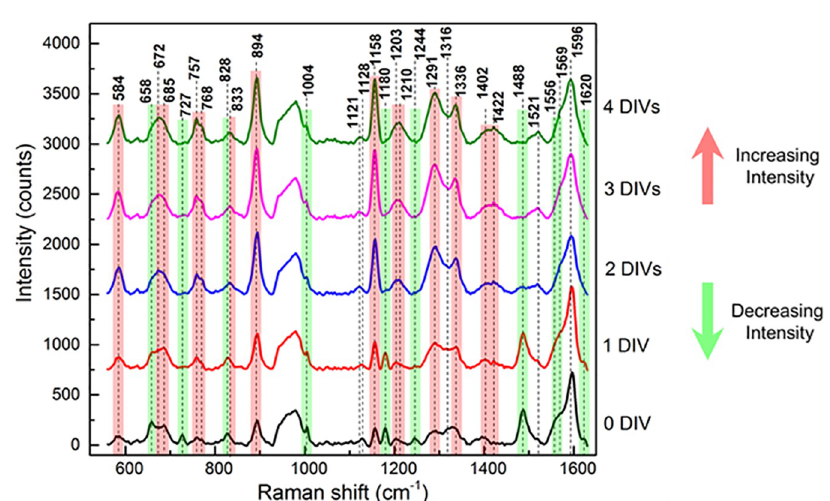
Fig 3. Raman spectraof the 3T3 conditioned medium collected from one to four DIVs. Raman spectra of DMEM culture medium collectedat different DIVs of mouse embryonicfibroblastsNIH/3T3 cell line. DIV0 corresponds to completeDMEM without conditioningwith cell culture. The measurements were donewith 532 nm laser line, 1 mW power and 10 second acquisitiontime in liquidconditions. The red and green lines indicatethe peaks with increasing and decreasing intensities,